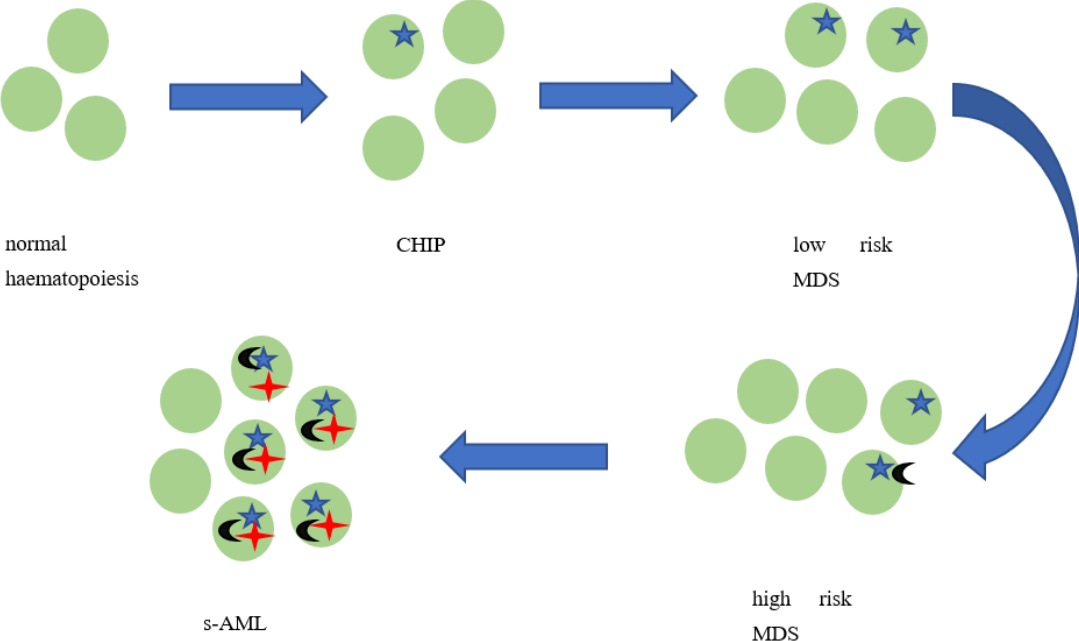
Figure 1. Clonal evolution: from normal haematopoiesis to secondary AML. MDS arises through the sequential acquisition of somatic mutations in recurrently involved genes. The earliest genetic step in MDS pathogenesis is “ clonal haematopoiesis of undetermined potential ” (CHIP) — An entity that describes the presence of somatic mutations in the blood or bone marrow cells, when no other criteria for hematologic neoplasia are met [19,20]. During MDS initiation, newly acquired mutations appear, while previous mutations are also carried forward. Some of those acquired mutations have no consequences as “ passenger ” mutations while others become driver mutations, contributing to clonal evolution [8]. The final stage of the disease progression is an evolution from MDS to s-AML, also occurring as a consequence of somatic mutations accumulation [18]. The whole process is called “ clonal evolution ” [8].